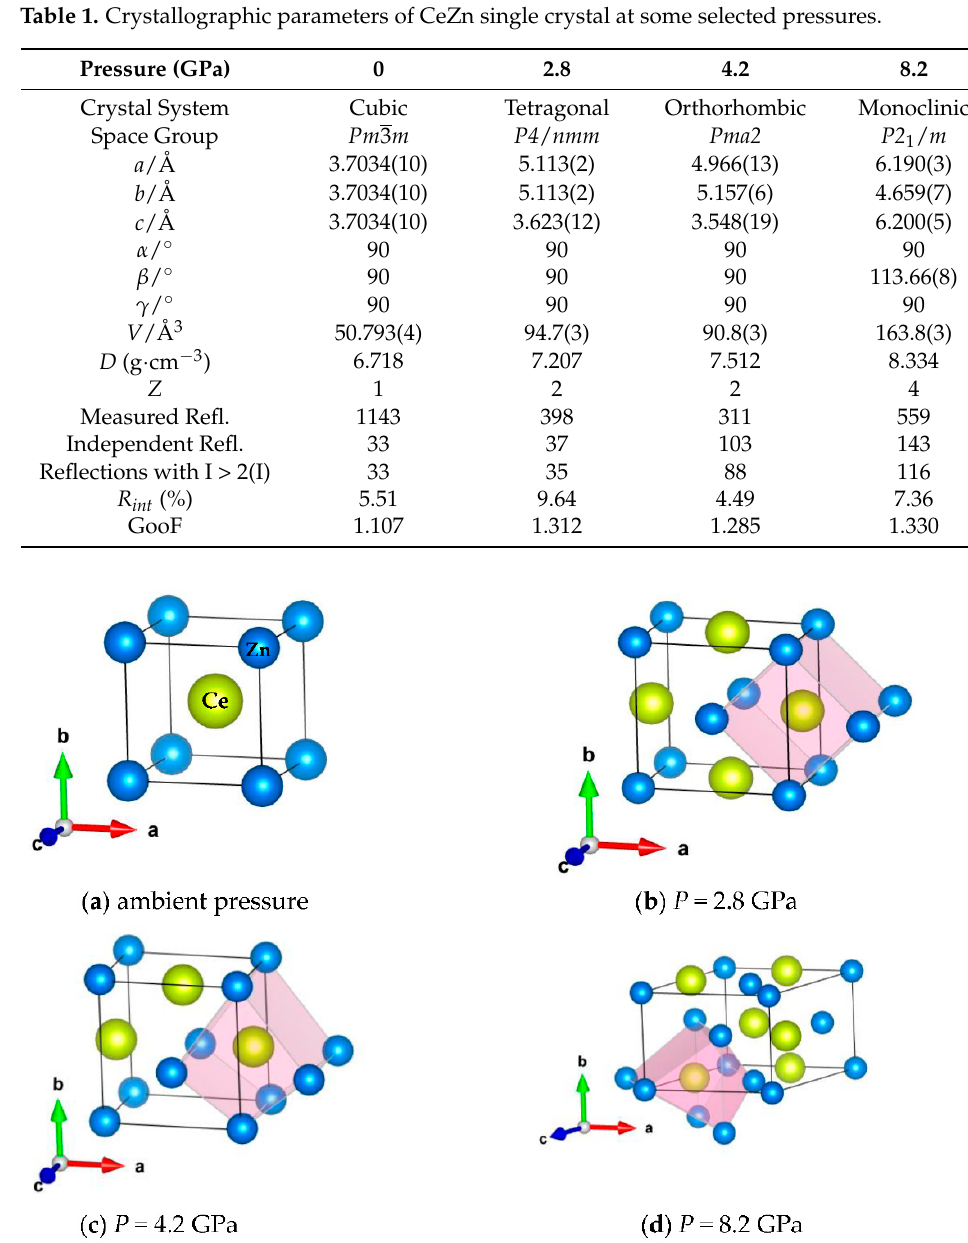
Figure 3. The crystal structure of the CeZn at some selected pressures. ( a ) Cubic structure at ambient pressure; ( b ) tetragonal structure at 2.8 GPa; ( c ) orthorhombic structure at 4.2 GPa; ( d ) monoclinic structure at 8.2 GPa. The pink outline shows the gradual distortion of the cube consisting of a Ce atom at the body-centered position surrounded by eight Zn atoms with increasing pressure.